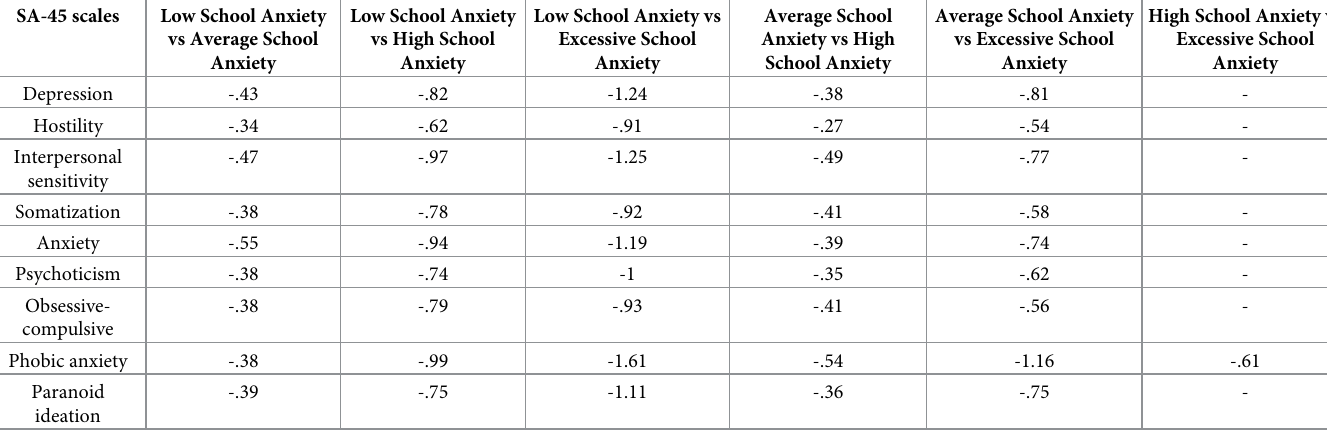
Table 4. Cohen’s d indices for post hoc contrasts between the mean scores obtained by the school anxiety profiles in psychopathological symptoms. SA-45